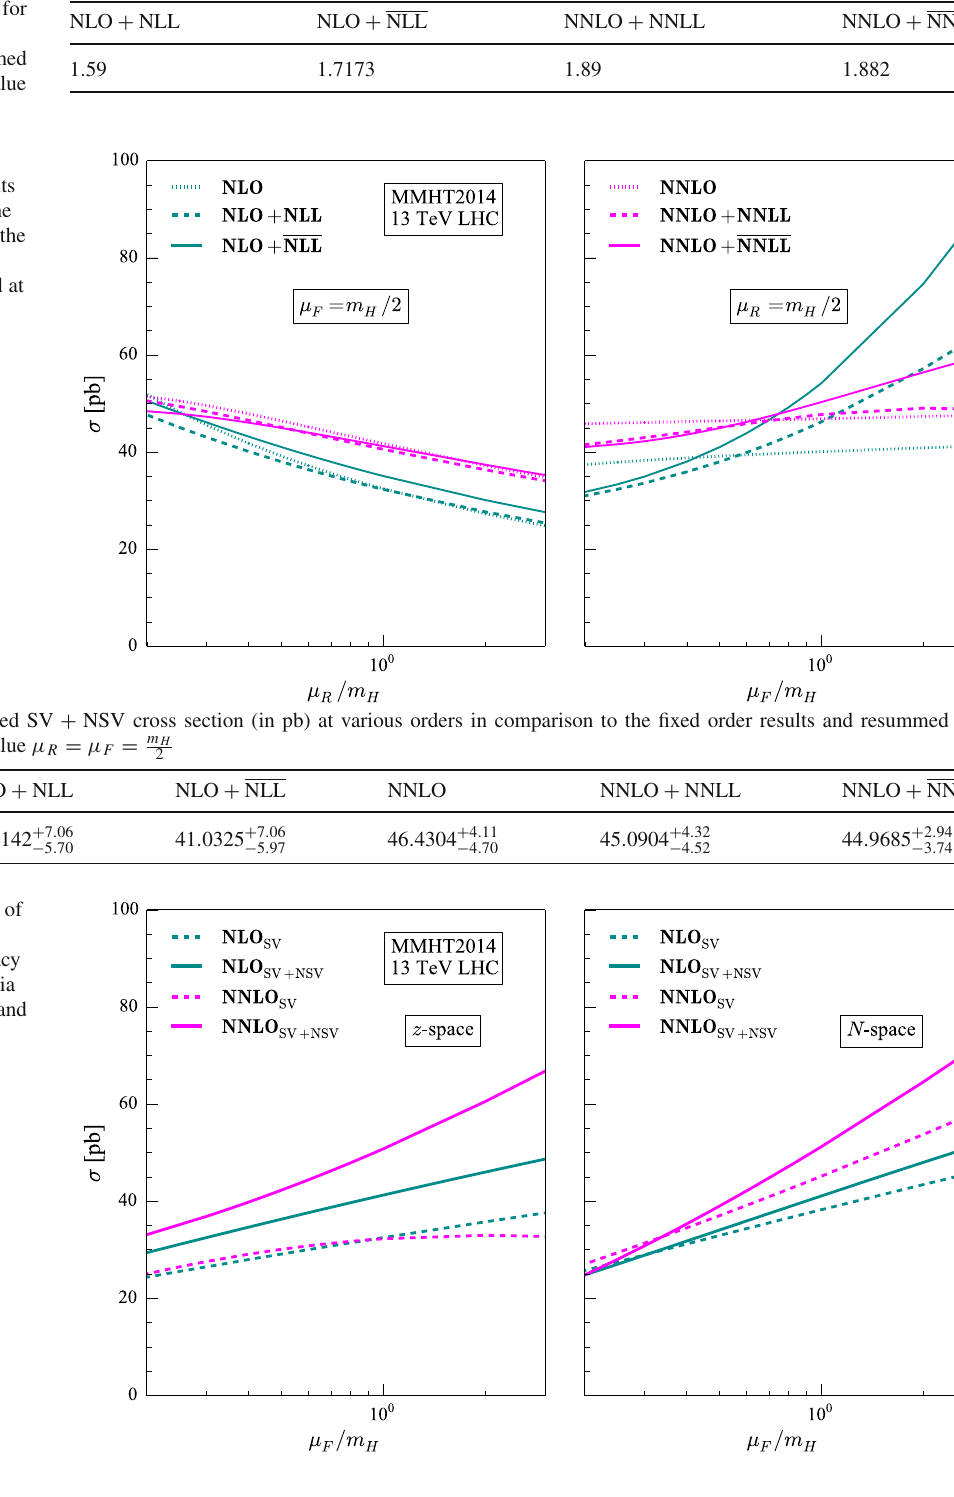
Table 9 The K-factor values for NSV resummed result in comparison to the SV resummed predictions at central scale value